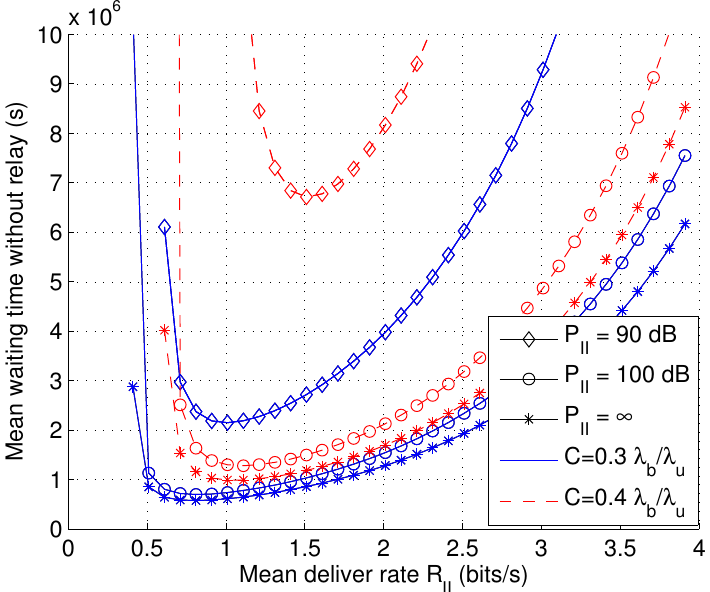
Figure 9. The mean waiting time ¯ w 1 as a function of average delivery rate R II with varying transmit II power P II and capacity demand C ( λ b = 10 − 6 , L = 1, v =